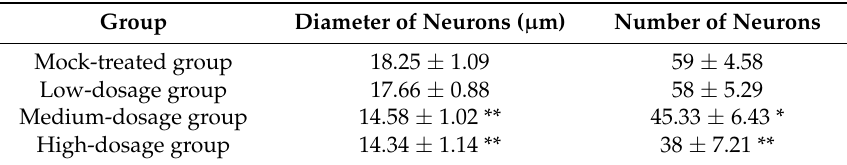
Table 1. Parameters of neurons in cerebral